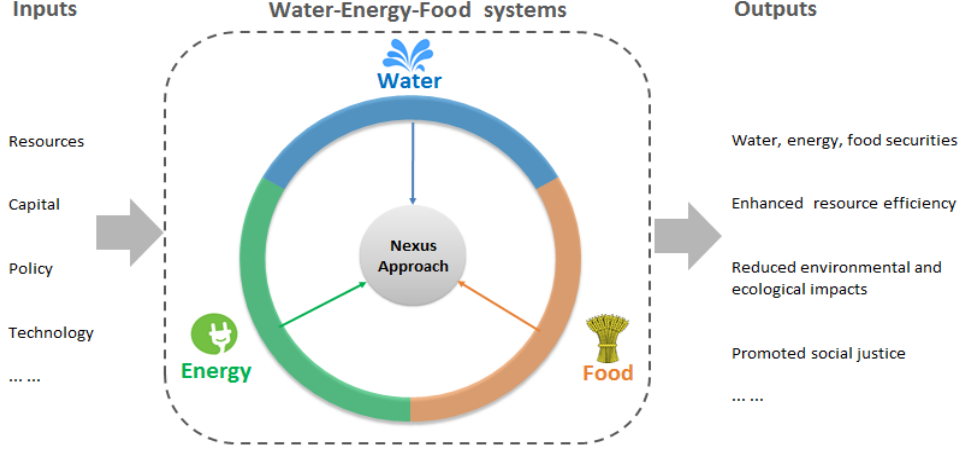
Figure 1. Water-energy-food (WEF) nexus management concepts